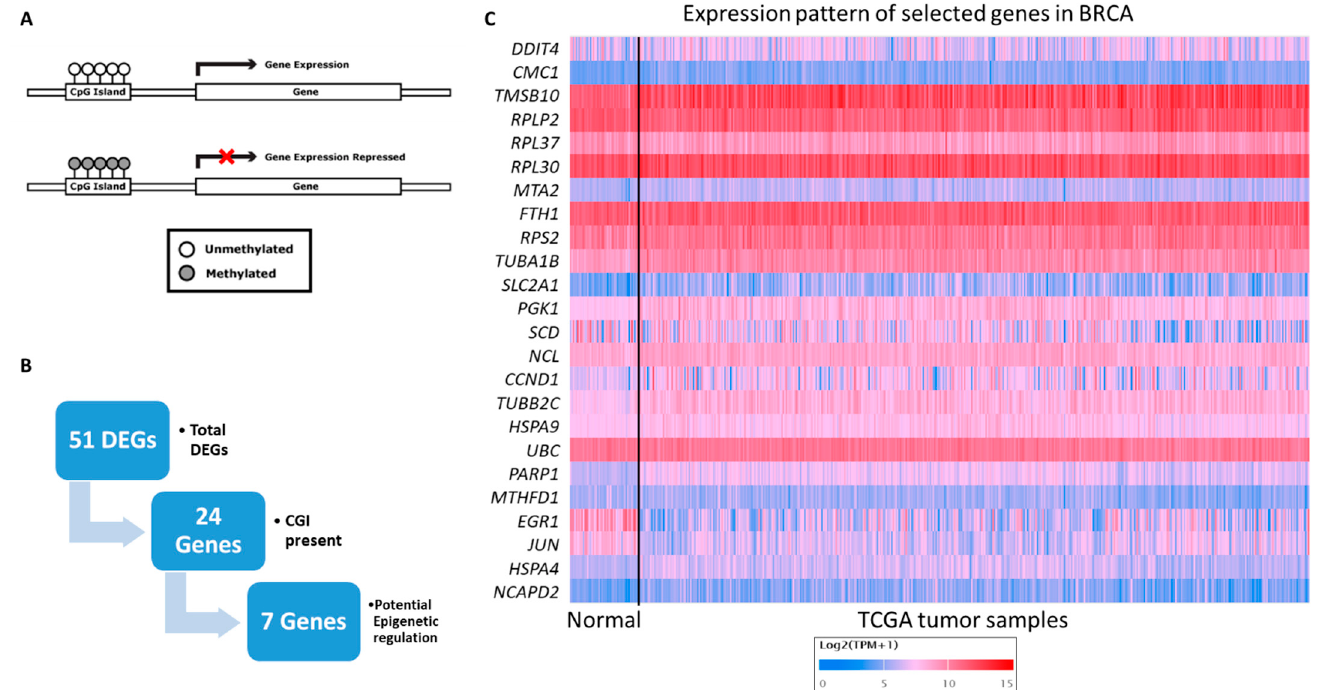
Figure 2. Gene filtration for identification of potential epigenetic regulation in breast cancer. ( A ). Line diagram showing DNA methylation induced epigenetic modulation of genes. ( B ). Flow chart showing the process of potential epigenetic target gene filtration. ( C ). Heatmap showing the expression pattern of 24 target genes with CpG islands (CGI) in their promoter regions in normal versus TCGA breast adenocarcinoma (BRCA) tissue samples.